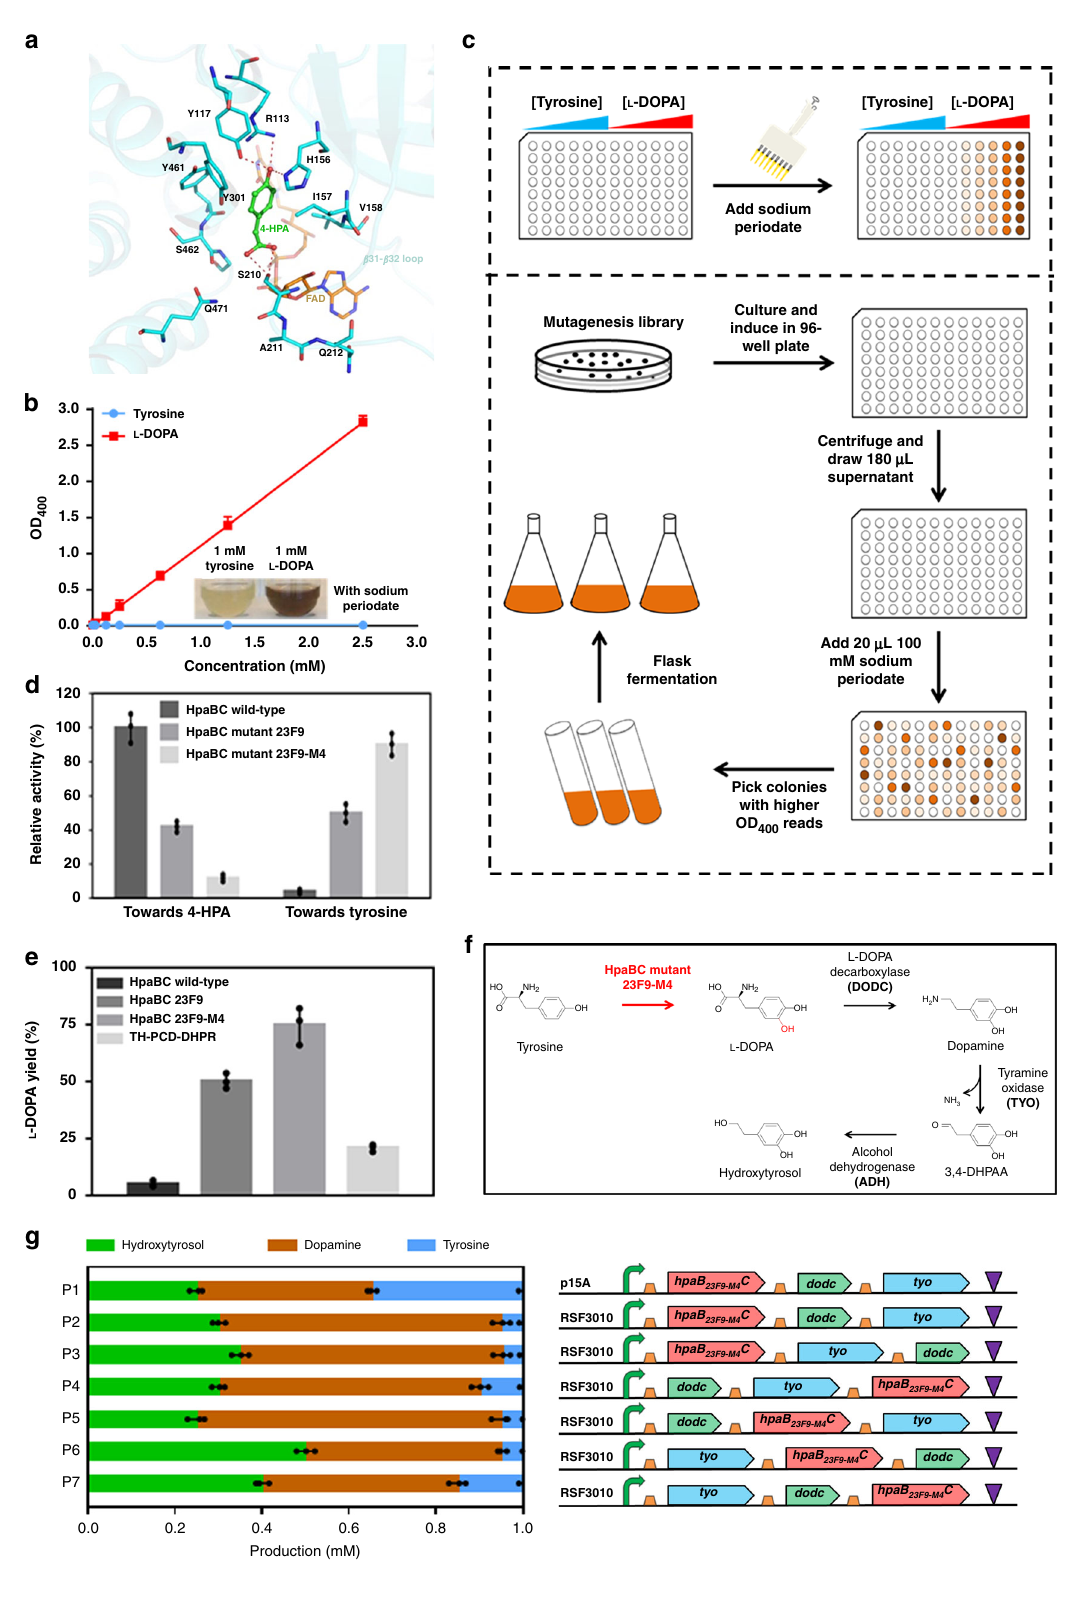
Redesign of the hydroxytyrosol bi3osynthetic pathway . The HpaBC mutant 23F9-M4 was used to redesign the hydroxytyrosol biosynthetic pathway, with the removal of the regeneration sys- tem of cofactor MH4 13 (Fig. 1f). The redesigned pathway was